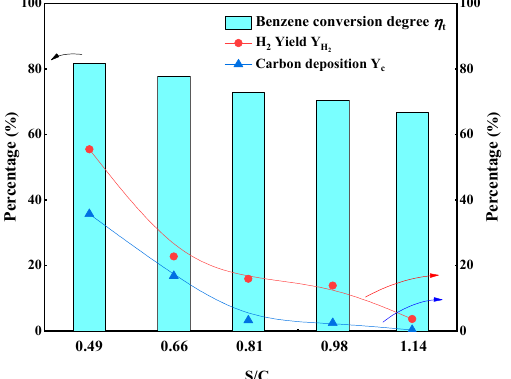
Figure 4. Effect of mass ratio on benzene cracking.